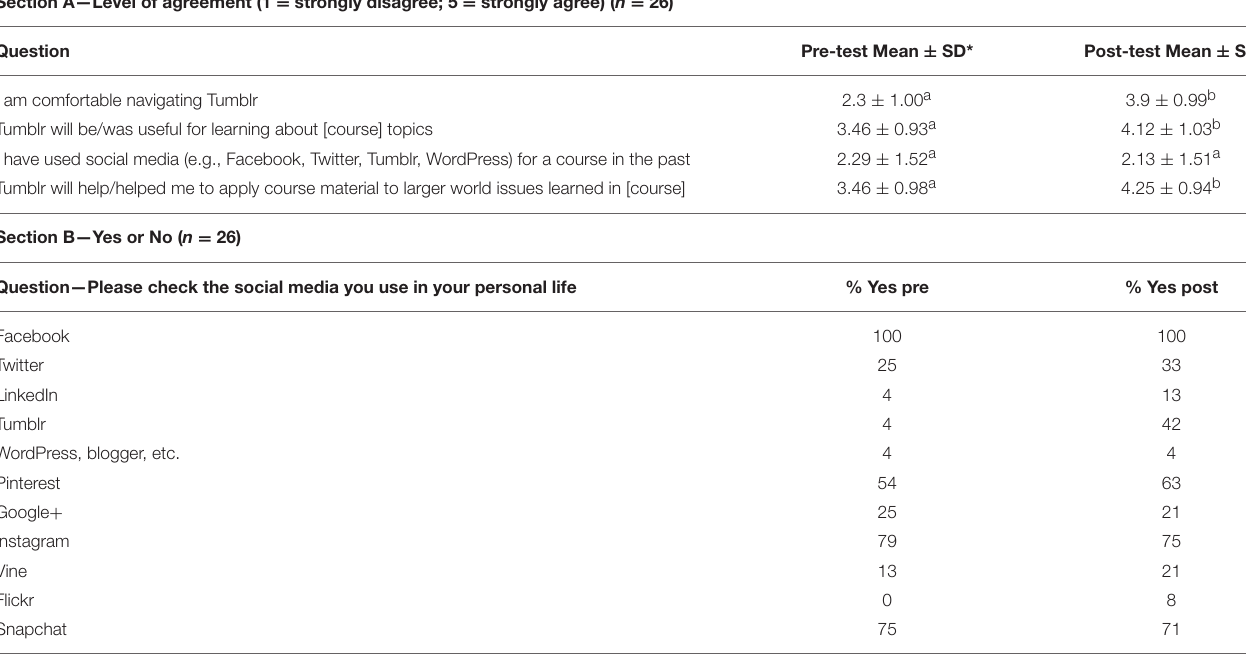
TABLE 3 | Mean pre and post test scores for Tumblr assignment from information literacy at Montana State University, Spring 2015. Section A—Level of agreement (1 = strongly disagree; 5 = strongly agree) ( n =